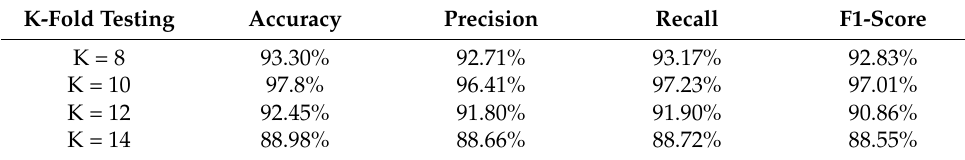
Table 4. Cross-validation for keratoconus detection.